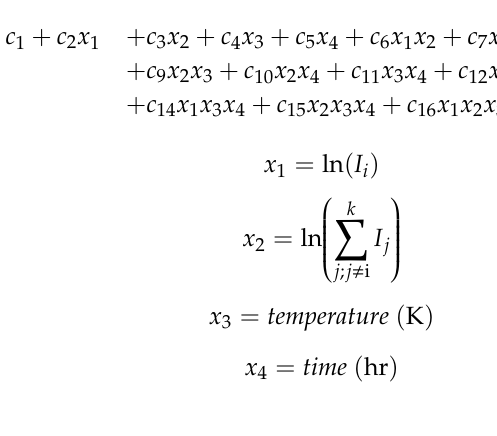
Table 8. Calibration Equations for Calcium and Chloride